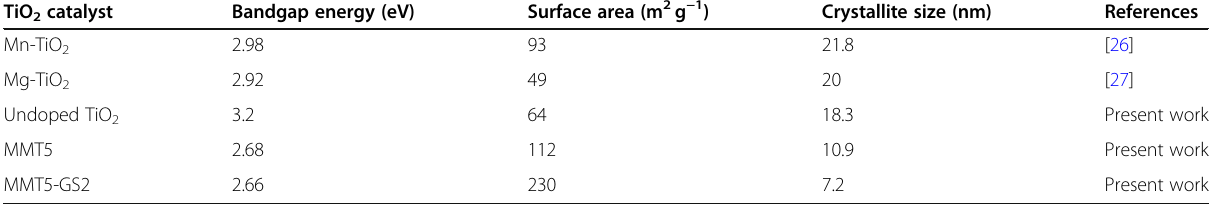
Table 3 Comparative study of Mn 2+ , Mg 2+ single doped and Mn 2+ /Mg 2+ bimetal doped TiO 2 nanocatalysts